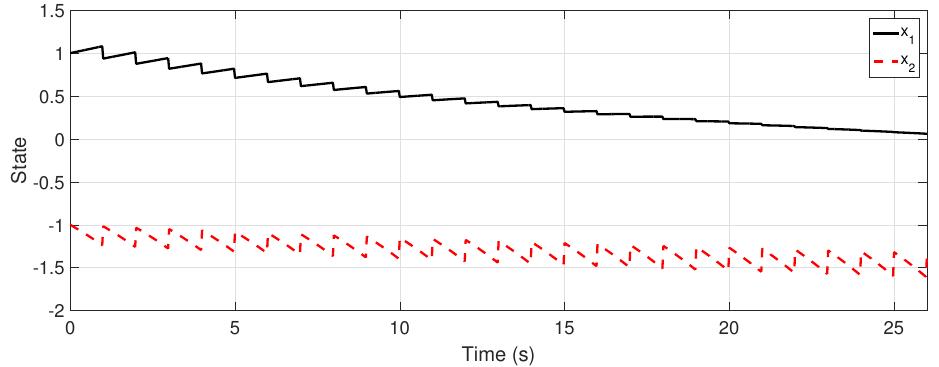
Figure 1. System trajectories for an arbitrary switching